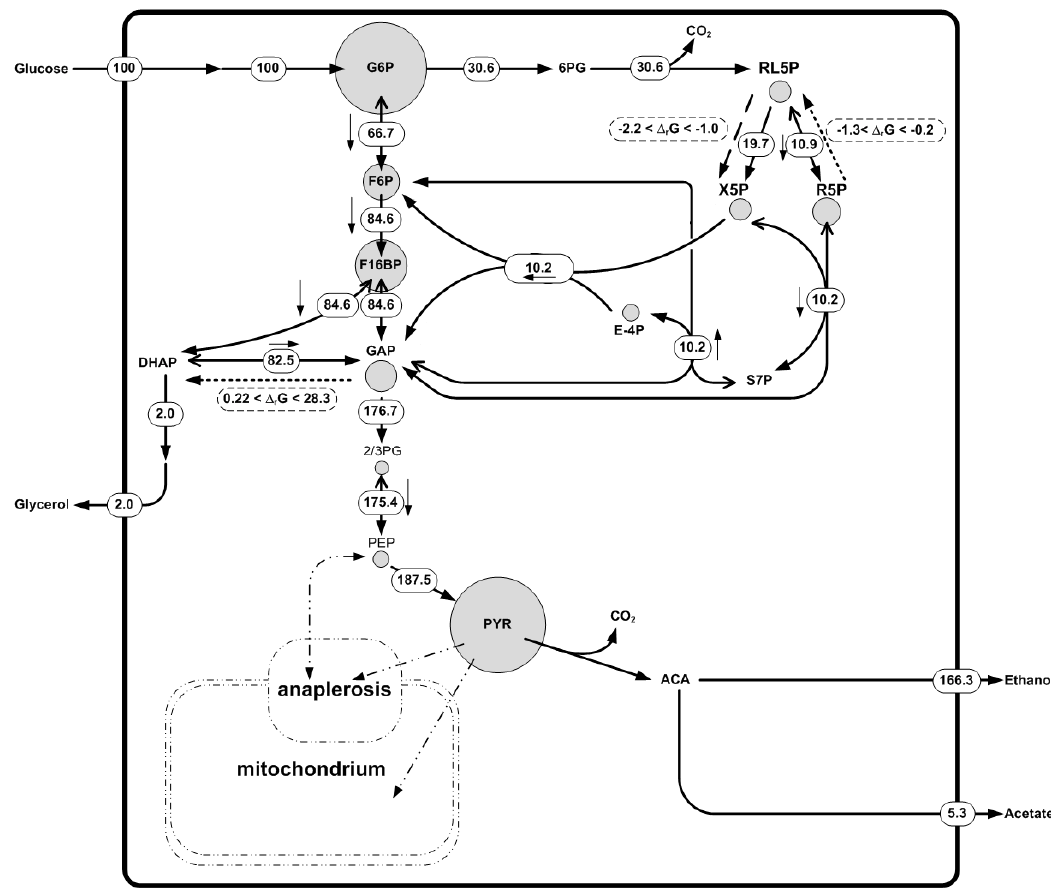
Figure 5. Intracellular metabolite concentrations and metabolic fluxes in Saccharomyces cerevisiae S288C during growth on glucose and glutamate as carbon sources in continuous culture. The dilution rate is 0.29. Metabolite concentrations are represented as circles corresponding to their concentration in [ μ mol/g CDW ]. Concentrations were set equal to mm 2 . After back-calculating to the radius of the circle, the 10-fold radius was used to create the circles in the figure. Net fluxes are presented. In the case of reversible reactions, depicted by a double arrow, the net direction is indicated with a small arrow next to the flux value. Δ r G values were predicted by using NExT . Dashed lines indicate flux direction based on thermodynamic modelling. Dotted lines show the predicted flux direction by the thermodynamic modelling contradicted by 13 C fluxomics where Δ r G is close to zero. For simplification, only a small section of the network is shown and for clarity some fluxes are omitted. Each metabolite node is balanced in the full network.